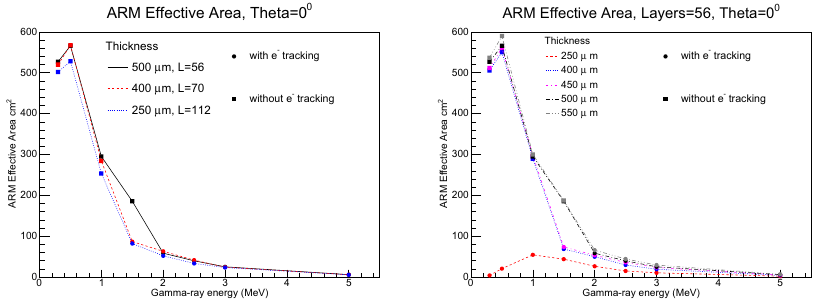
Figure 5: E ff ective area from the reconstruction of Compton events, Left panel: Fix the radiation length. Right panel: Fix the number of